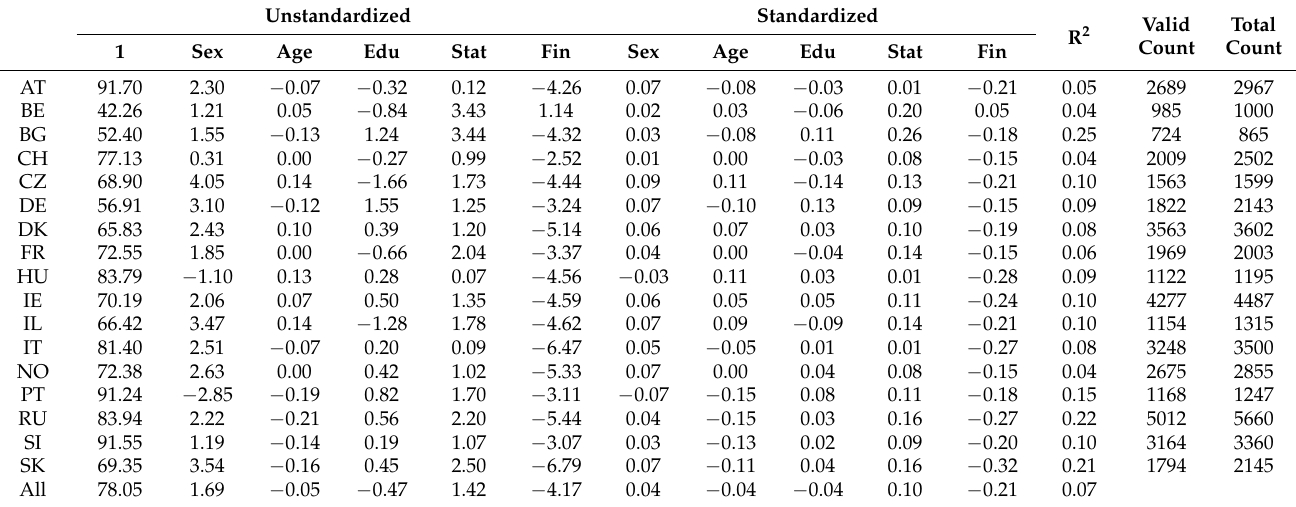
Table 13. Multivariable linear regression models of the type D score by five core social determinants (standardized coefficients ( β ) and R 2 ), for each country and for all countries (equally